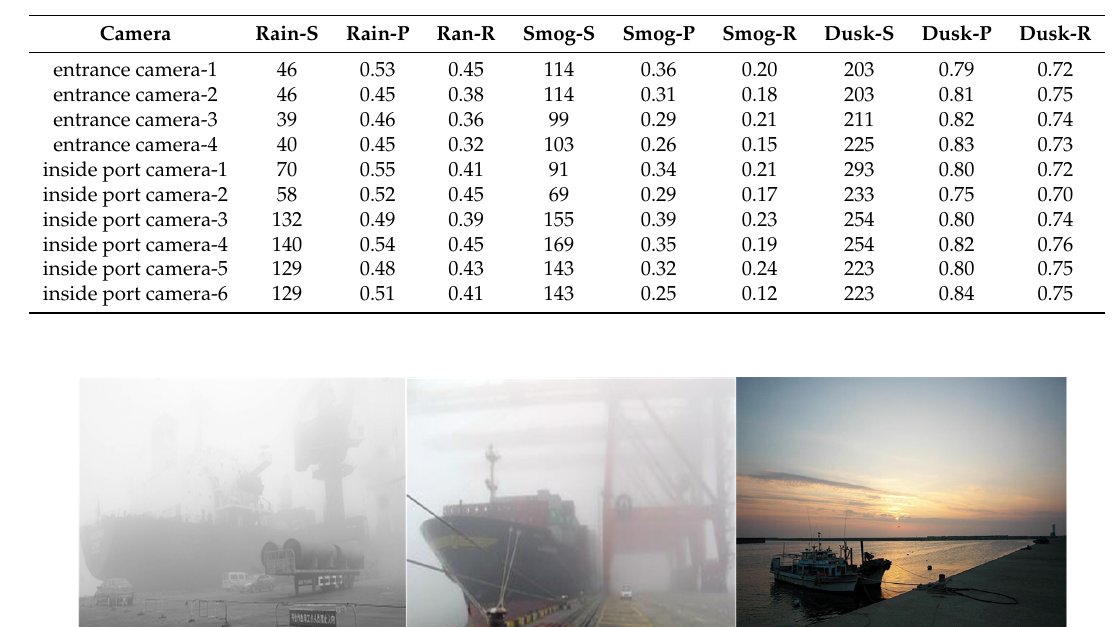
Table 10. Performance of ship recognition in bad weather.